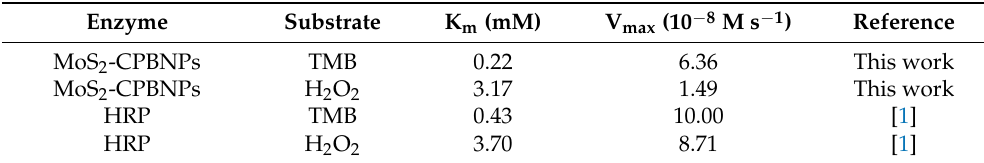
Figure 3. Steady-state kinetic study of MoS 2 -CPBNPs nanozymes. The reaction rate was tested by tuning the concentration of ( A ) TMB and ( B ) H 2 O 2 . ( C ) Lineweaver – Burk plot obtained by fixing 20 mM H 2 O 2 with different concentrations of TMB (0.01 – 0.1 mM). ( D ) Lineweaver – Burk plot obtained by fixing 0.1 mM TMB with different concentrations of H 2 O 2 (1 – 20 mM). All the experiments were Table 1. Comparison of apparent kinetic parameters of as-prepared MoS 2 -CPBNPs nanozymes and HRP enzyme.